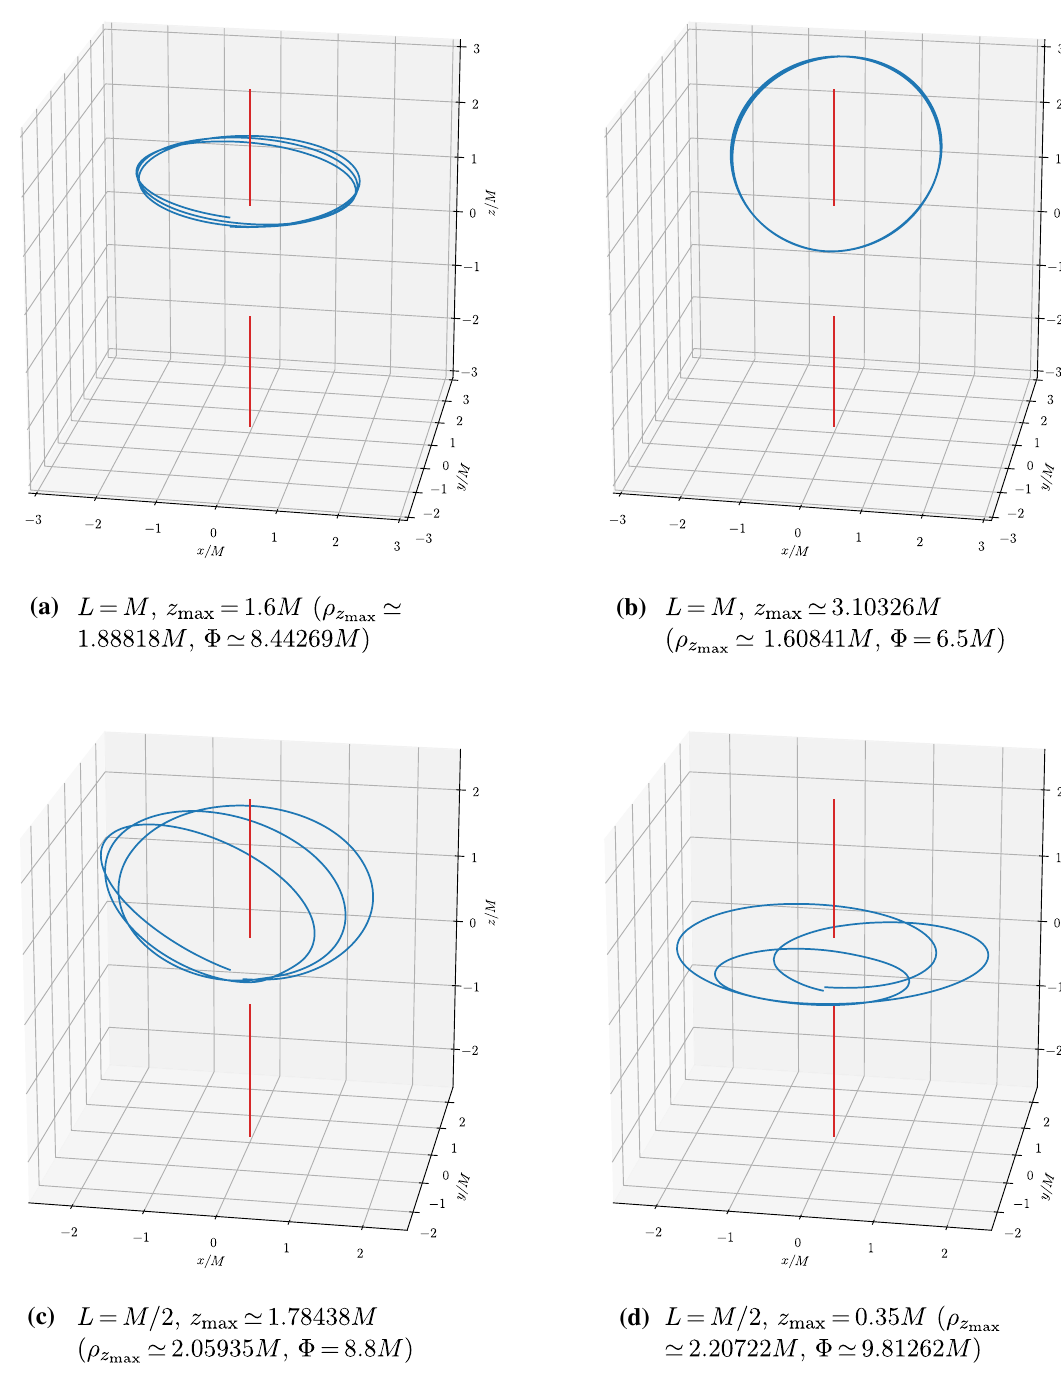
Fig. 11 Examples of Class B FPOs for four different values of L and z max as indicated. The orbits start at z min in all four plots, and terminate after the interval (cid:10)φ = 6